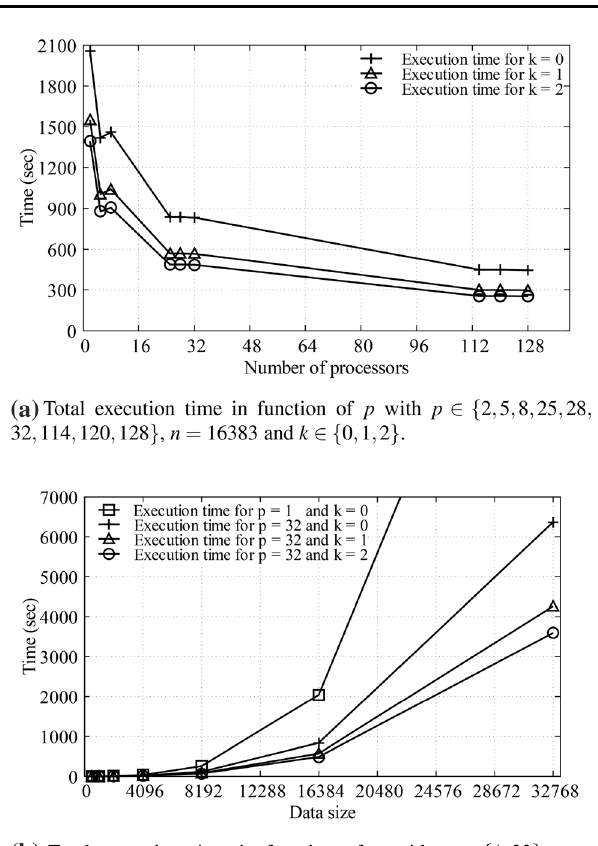
Fig. 9 Global communication time and computation rate versus com- munication rate